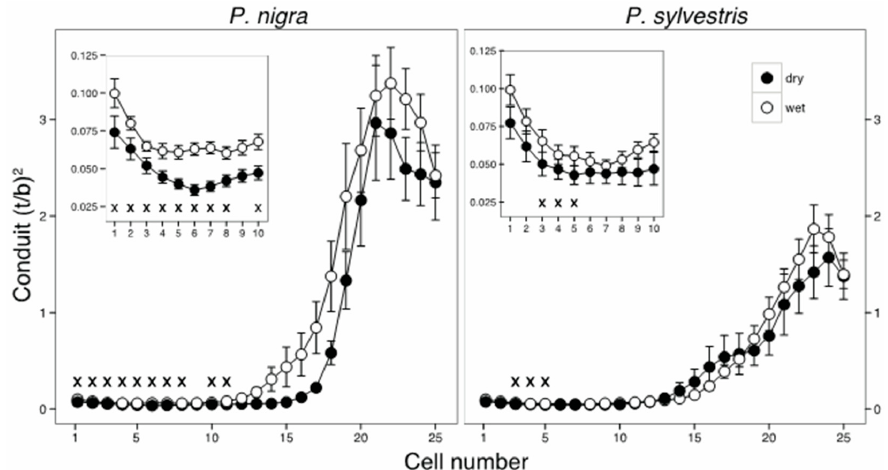
Figure 5. Mean tracheidogram of conduit hydraulic safety (expressed as the (t/b) 2 relationship) for P. nigra and P. sylvestris for dry and wet years. Inset boxes show detail of normalized cells 1 through 10 of each tracheidogram where significant differences between wet and dry years were observed. Vertical bars represent standard error of the mean. Within each species, (x) indicate cells for which hydraulic safety is significantly different ( p < 0.05) between dry and wet years Table 3. Wood and tracheid properties in Pinus nigra and P. sylvestris pine (means and standard deviation) calculated for years with SPEI12 classified as being average, dry or wet for the period 1960–2006. Different letters within a row indicate significant differences at the p = 0.05 (except those with * which are significant at the p = 0.10) in the linear mixed model approach. EW, earlywood; LW, latewood. Data for year 1991 was removed from the